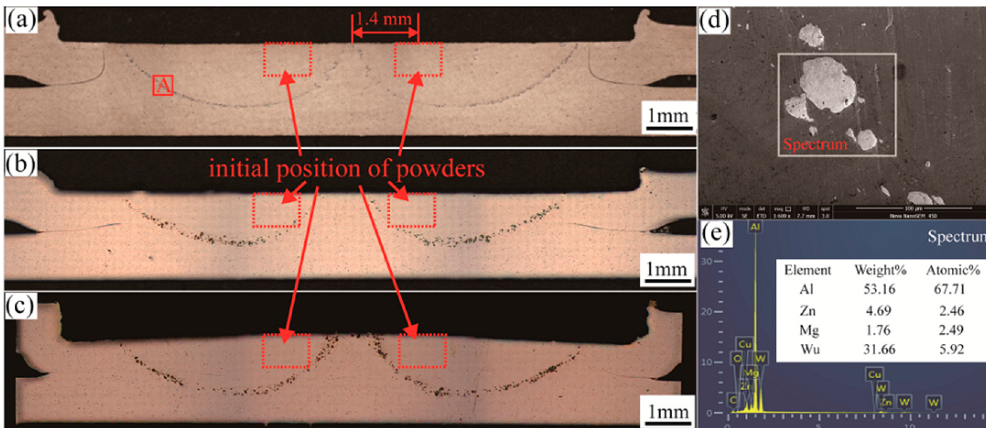
Figure 5. Distribution of tungsten powders in the cross sections of the joints produced by ( a ) the archimedes tool, ( b ) involute tool, ( c ) and concave tool and where ( d ) SEM image and ( e ) EDS spectra were obtained from region A.